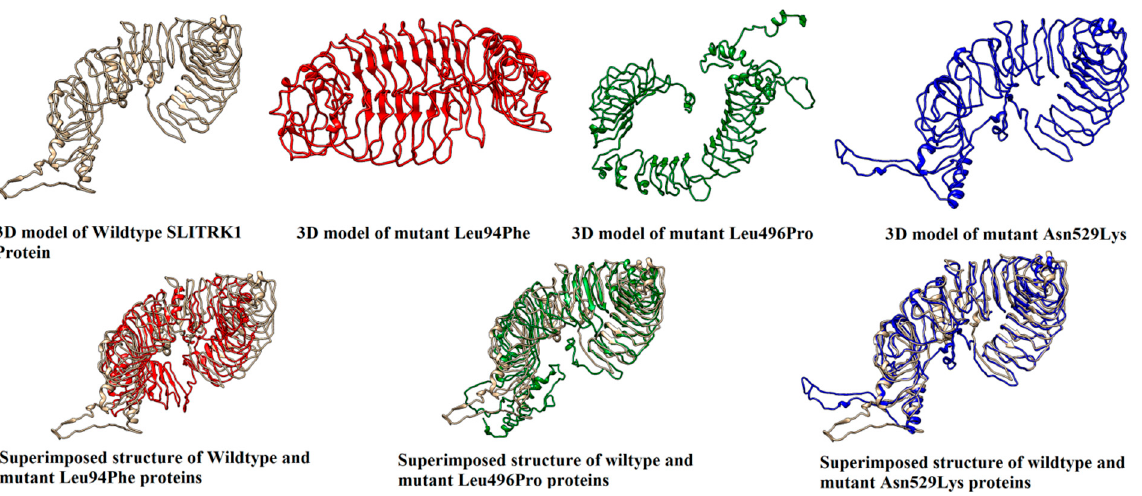
Figure 5. Three-dimensional structure of the SLITRK1 wild type protein, its variants, and the superimposed structures of the wild type and variants.